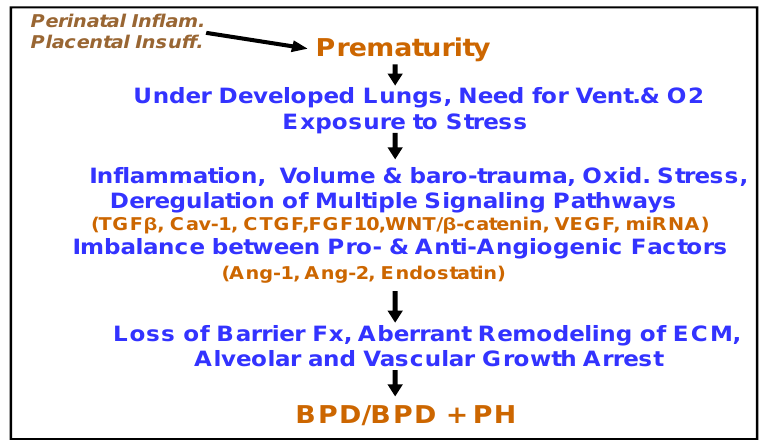
Figure 1. This figure recapitulates the development of bronchopulmonary dysplasia (BPD)/BPD+ pulmonary hypertension (PH) in premature infants. Ang-1 = angiopoietin-1, Ang-2 = angiopoietin-2, Barrier Fx = barrier function, ECM = extracellular matrix, Oxid= oxidative, Placental Insuff = placental insufficiency, Perinatal Inflam = perinatal inflammation, Vent = ventilation.